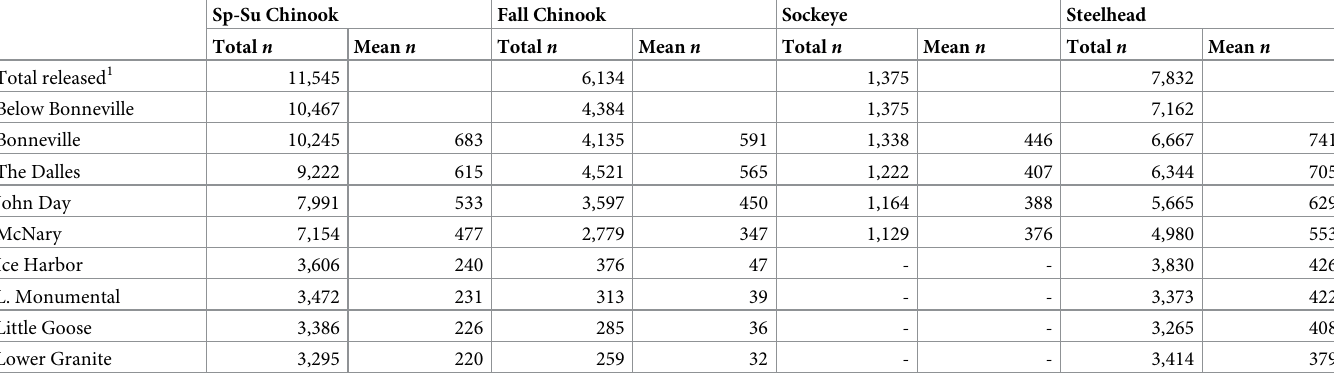
Table 3. Total and annual mean numbers of radio-tagged adult Chinook Salmon, Sockeye Salmon, and steelhead detected at the eight lower Columbia River and lower Snake River study dams, 1996–2014. The total released includes those released from the Bonneville Adult Fish Facility and into the Bonneville forebay. Sockeye Salmon detected at Snake River dams ( � 3/year) not